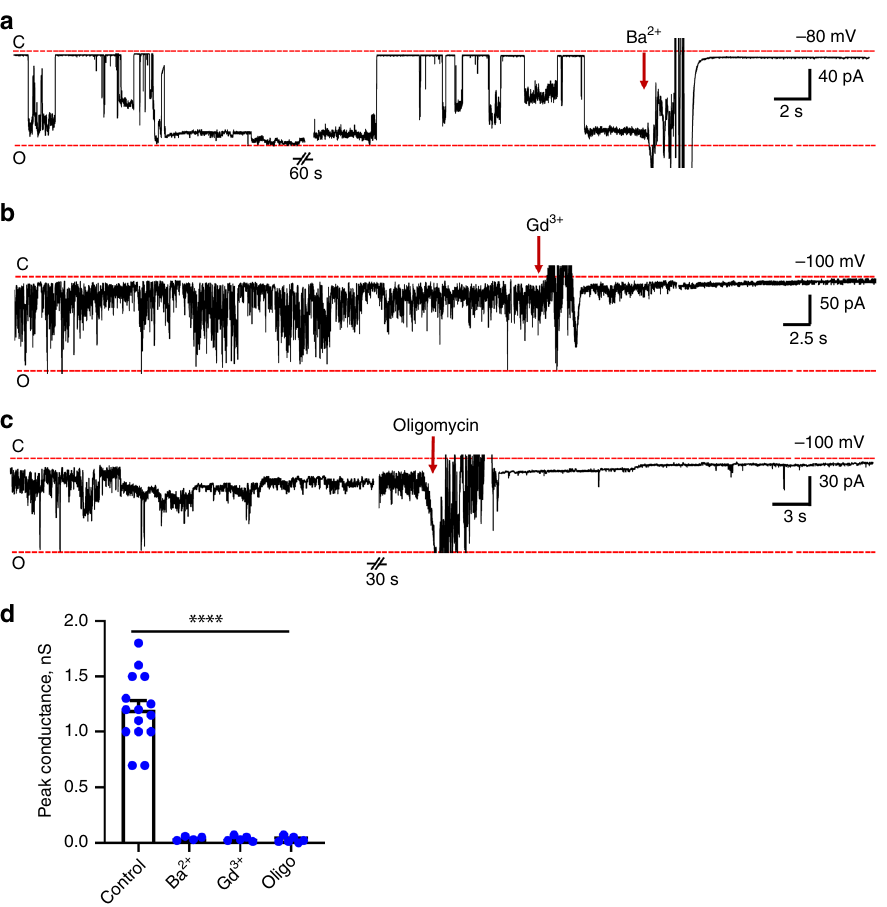
Fig. 5 Pharmacological modulation of ATP synthase channel activity. Representative patch-clamp recording of F 1 F O ATP synthase reconstituted liposomes showing sensitivity to a Ba 2 + (1 mM), n = 4, b Gd 3 + (1 mM), n = 5, and c oligomycin A (5 μ g/ml), n = 6. During the oligomycin experiment, the closure of the channel was not observed when the vehicle, ethanol, was added during the recordings. C, indicates the closed state, O indicates the open state of the channel. d Group data for the peak conductance of ATP synthase channel activity for the conditions noted in a , b , and c . One-way ANOVA test was used for statistical analysis, **** P < 0.0001, error bars refer to SEM. The source data underlying d are provided as a Source Data fi